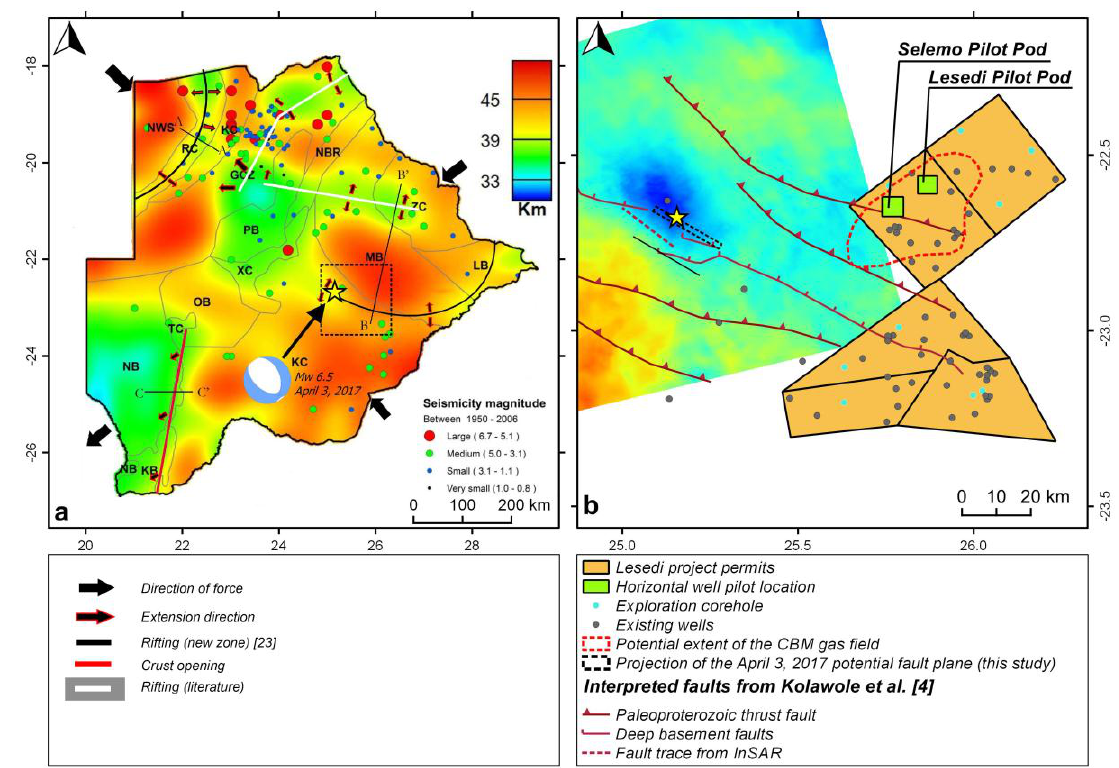
Figure 6. ( a ) Location of the 3 April 2017 M w 6.5 Botswana earthquake on the map showing the crustal thickness of Botswana (contours) and the geodynamic interpretation. Figure modified from Chisenga [30]. The gray lines indicate the major tectonic province and the letters represent names of tectonic province: NWS = north western group, ZC = Zimbabwe craton, RC = Roibok complex, KC = kwando complex, GCZ = Ghanzi-Chobe zone, NBR = North Botswana rift, PB = passarge basin, XC = Xadi complex, MB = Magondi belt, LB = Limpopo belt, OB = Okwa belt, TC = Tshane belt, KB = Kheis belt, NB = Nossop basin and KB = Kaapvaal belt. ( b ) Detail of the area bordered by the dashed black square in panel ( a ), showing the location of the retrieved fault geometry respect to the Lesedi project permits (http://tlouenergy.com/lesedi-cbm-project) and the tectonic structures inferred from 3D aeromagnetic and gravity data [4]. The colored map shows the LoS ground displacements from InSAR data (see Figure 2b). Coordinates are in the wgs84 datum.